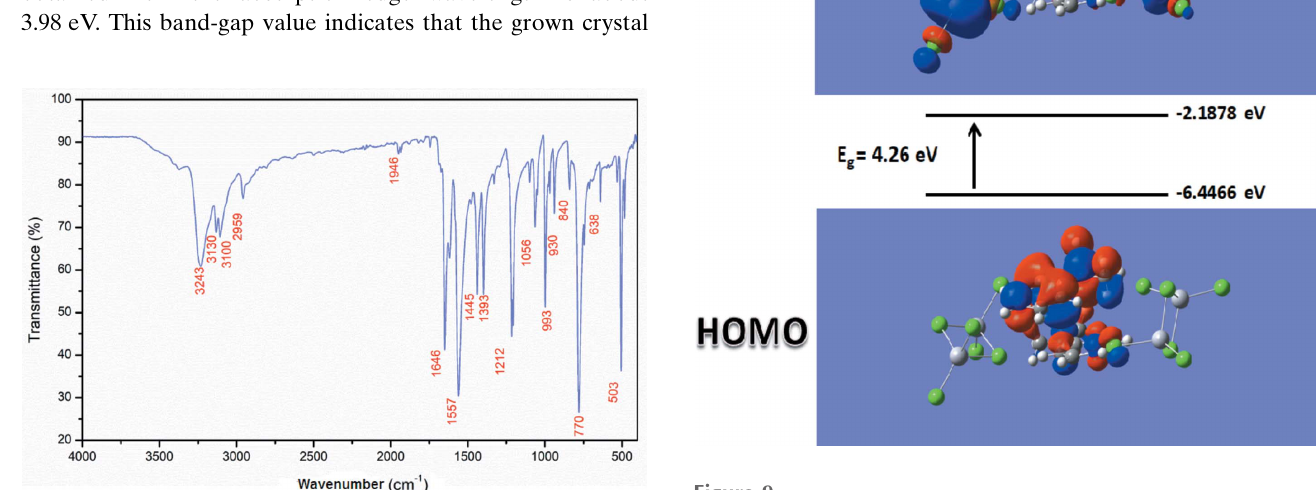
Figure 7 Infrared spectrum of (I).